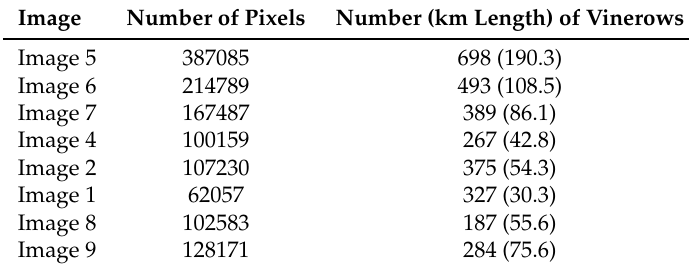
Table A2. Vinerow ROI counts.